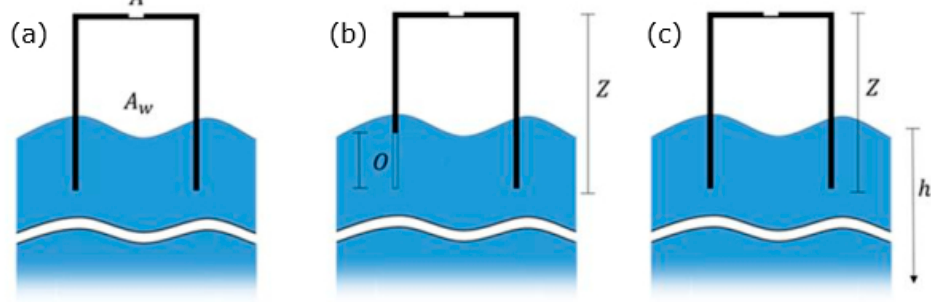
Figure 6. Parameters to be examined in the study: ( a ) Ratio of orifice area, R A = A/A w ; ( b ) Ratio of front gate opening, R O = O/Z ; ( c ) Ratio of chamber height, R Z = Z/h (after Lee et al., 2021).